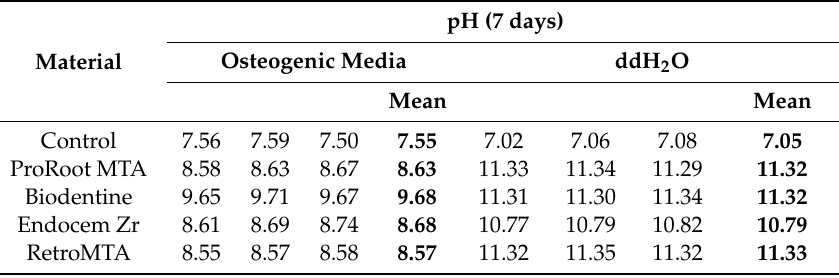
Figure 5. Relative rate of mineralized nodule formation based on Alizarin red staining assay. Different superscript letters indicate statistically significant differences (scale bar = 500 μm). Table 2. The pH of each experimental calcium silicate-based cement.